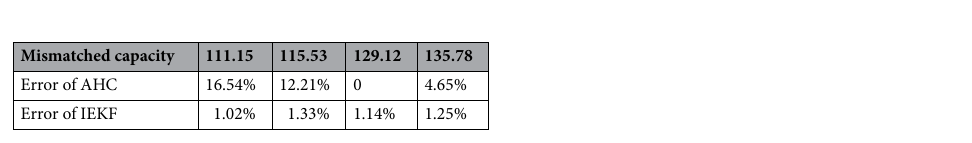
Table 10. SOC precision comparation between AH-integrity and IEKF.